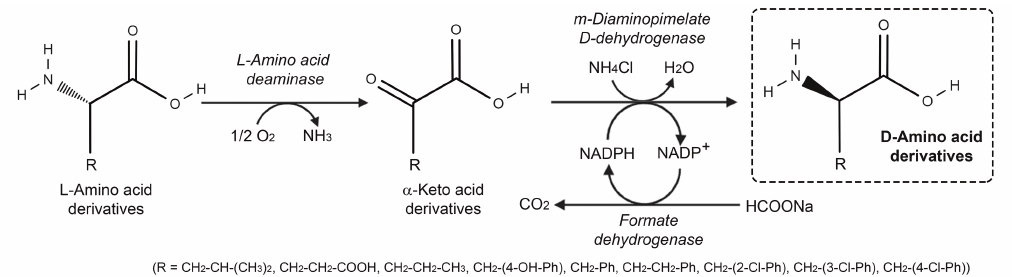
Figure 4. One-pot stereoinversion of L-AAs by P. mirabilis L-amino acid deaminase and recombinant meso -diaminopimelate D-dehydrogenase from S. thermophilum ; formate dehydrogenase was used to regenerate